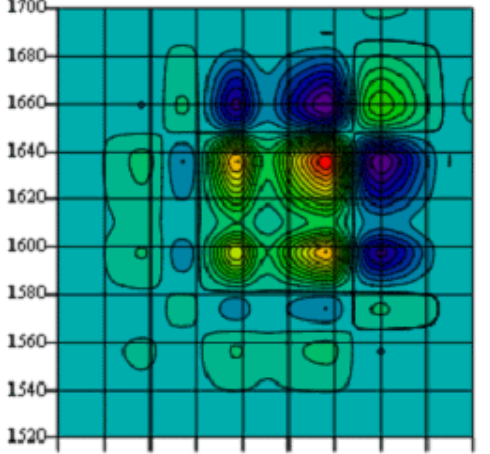
FIGURE 1. Two-dimensional correlation Synchronous plot for the n = 4,5 13 C=O labeled peptide below the transition temperature (T = 0–40 o